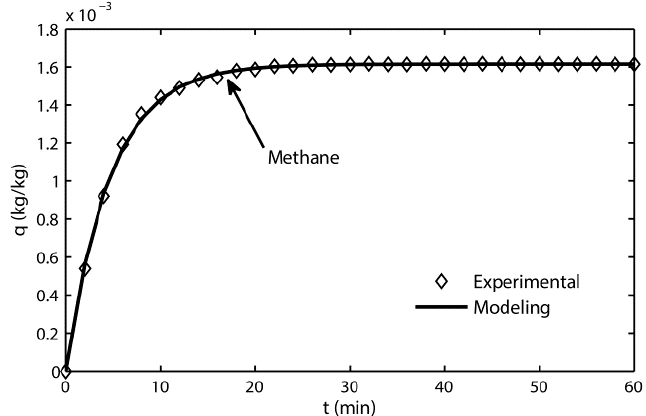
Figure 4. Experimental and modeling adsorption curves for methane.